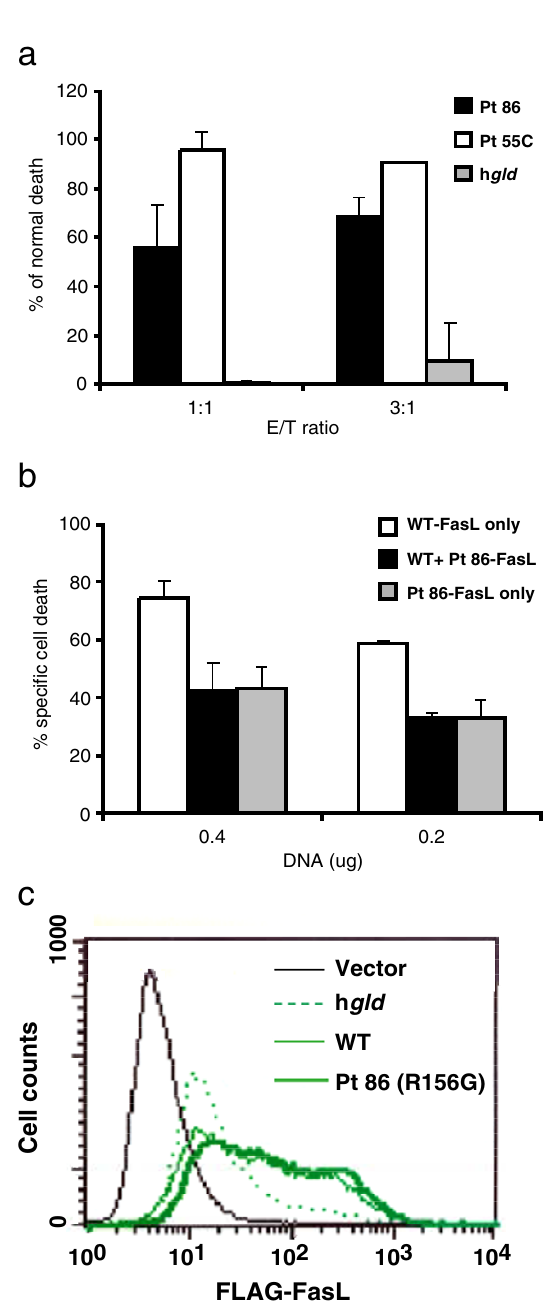
Figure 4 Cytotoxic effects of transfected FasL constructs on Jurkat cells. Cytotoxicity is reflected by the percentage of Fas-positive Jur- kat cells killed by co-culture with transfected 293T cells. (a) Ratios of 1:1 or 3:1 were used for 293T cells (effectors) trans- fected with either of 4 constructs (WT; Pt 86, black; Pt 55C, open; and h gld , shaded) to Jurkat cells (targets). Averages of % cell death and error bars are shown as normalized to that of WT FasL-induced death. Data represent at least 3 experiments. (b) Cotransfection of the Pt 86 (R156G) mutant FasL with wild type FasL. 293T cells were transfected with a total of 0.4 or 0.2 μ g of wild-type FasL only (open bars); with Pt 86 mutant mixed with wild-type FasL at ratio of 1:1 (black bars); and with Pt 86 mutant FasL only (shaded bars). The ratio of effector to target cells was 2:1 in this experiment. Means and error bars of the percentage Jurkat cells death are shown. Data represent two independent duplicate experiments. (c) Surface staining of FLAG- tagged FasL in 293T cells transfected with empty vector, h gld-, WT -, and Pt 86- FasL as